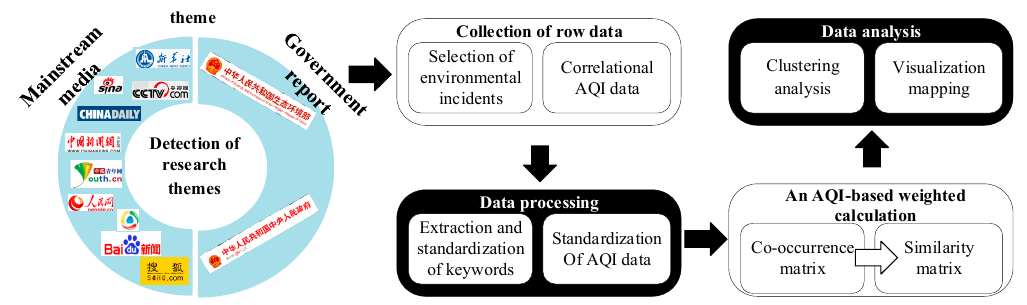
Figure 1. The process of the AQI-based weighted co-word analysis.